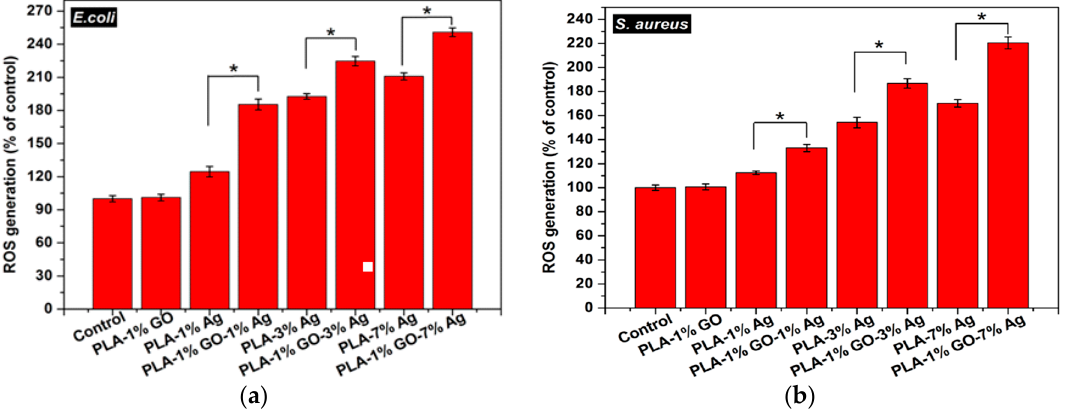
Figure 15. ROS levels in ( a ) E. coli and ( b ) S. aureus treated with electrospun PLA (control) and its nanocomposite mats. * denotes statistically significant difference between the test groups (* p < 0.05). Reprinted with permission from [165], Copyright American Chemical Society, 2017.